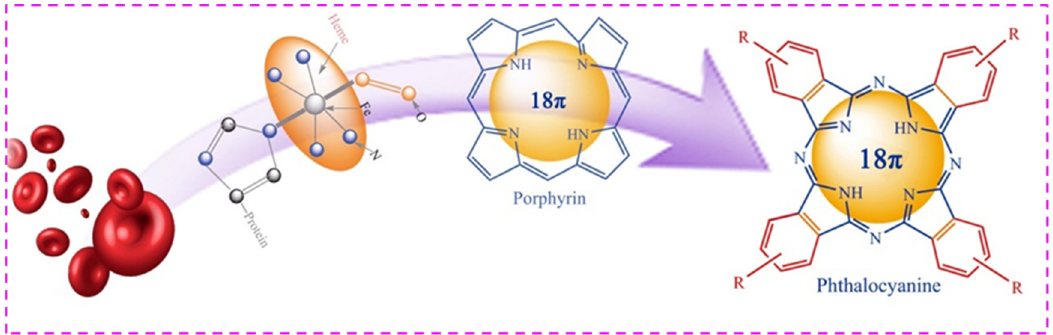
Figure 1. Biomimetic oxygen carrier function of